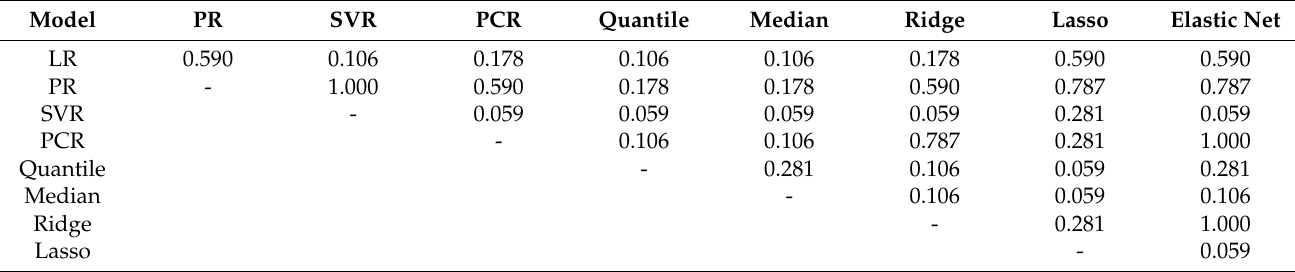
Table 7. p -values of Wilcoxon test for Ra in turning.